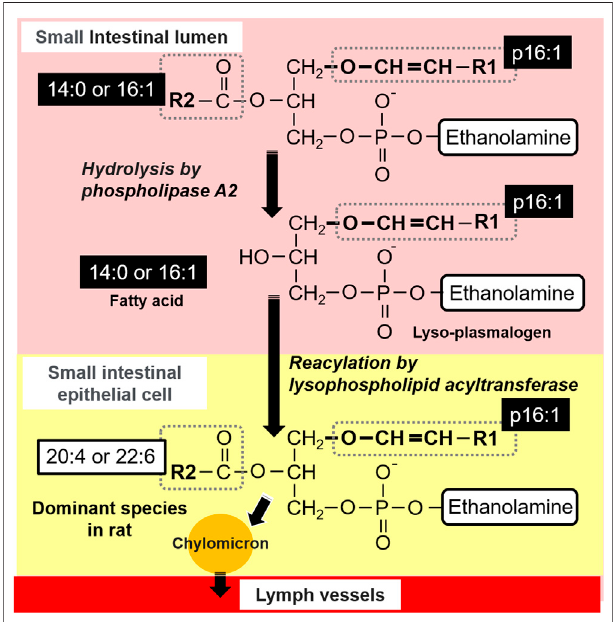
FIGURE 8 | Predicted lymphatic adsorption of plasmalogens from S. ruminantium in rats.